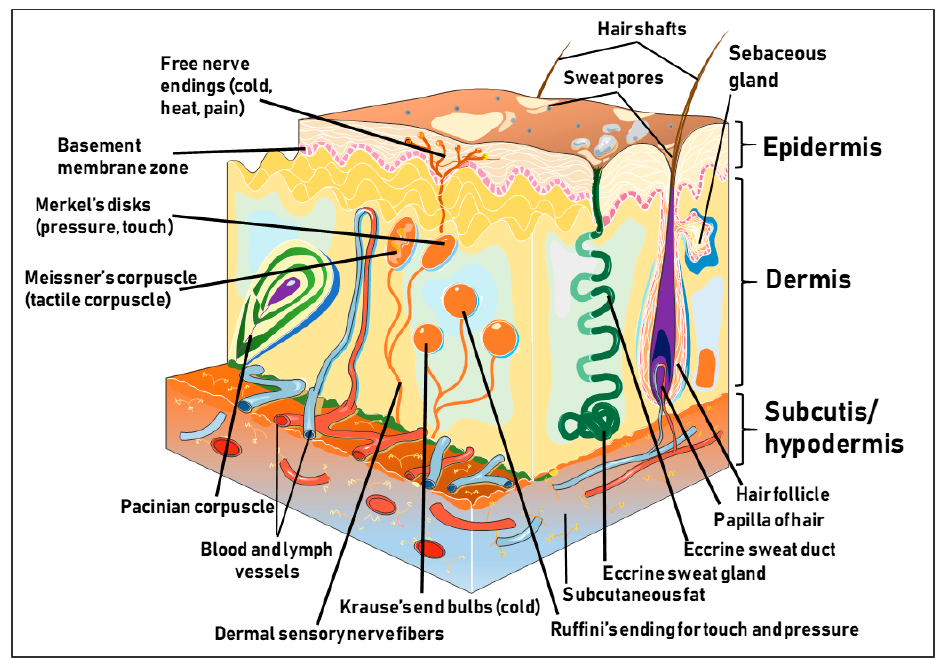
Figure 1. Schematic representation of the cross section of the skin. The skin is composed of epidermis, dermis, and hypodermis. The dermis supports and provides nourishment to the overlying epidermis through its constituent blood and lymphatic vessels. The skin also comprises sensory elements, various resident cell types like fibroblasts, macrophages, and lymphocytes. The ectodermally derived appendage such as sweat glands, sebaceous glands, and hair follicles arises as an invagination of the epidermis into the dermis. The epidermal stem cells are found in the bulge region of the hair follicles, in the basal layer of the interfollicular epidermis, and to some extent the sebaceous